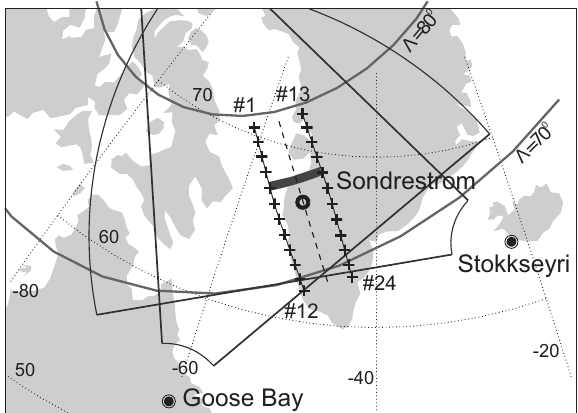
Fig. 1. Viewing zones of the Goose Bay and Stokkseyri Super- DARN HF radars, location of the Sondrestrom incoherent scatter radar (circle) and an ionospheric area (outlined by crosses) through which the Sondrestrom radar has been scanning for plasma drift measurements (at a height of 400 km). The direction of the Sondre- strom radar beam cycling was from the beam position correspond- ing to point #1 to beam position #12 and, after quick antenna reposi- tioning, from direction #13 to direction #24. Also shown are PACE lines of equal magnetic latitudes 3 =70 ◦ and 3 =80 ◦ . The dark band indicates one of the regions used for data